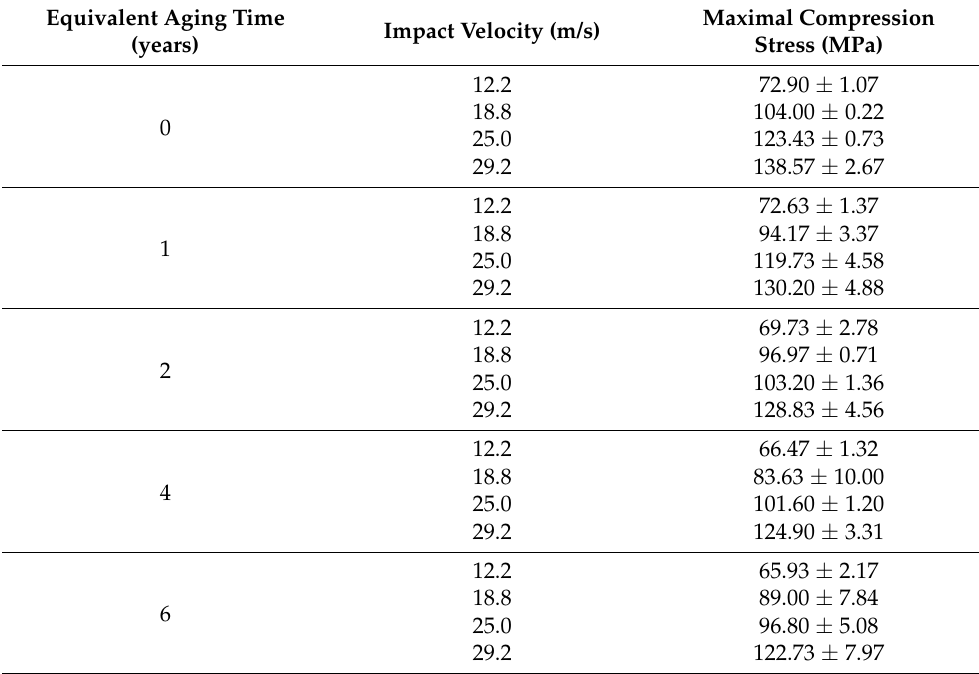
Figure 12. Maximal compression stress under different impact velocity with different equivalent aging time. Table 5. The maximal compression stress under different impact velocity and equivalent aging